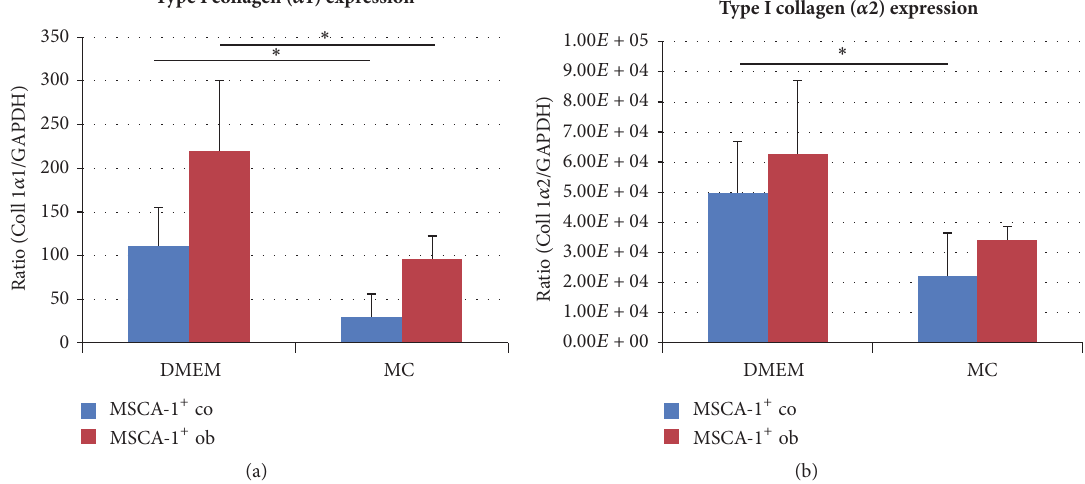
Figure 7: Quantitative PCR measurements of type I collagen ( 𝛼 1 and 𝛼 2 chain) gene expression levels in MSCA-1 + JPCs cultured under DMEM (serum-containing) and MC conditions (serum-free). (a) mRNA levels of type I collagen ( 𝛼 1 chain) and (b) ( 𝛼 2 chain) in relation to the housekeeping gene GAPDH are illustrated in untreated (co) and osteogenically induced (ob, for 10 days) MSCA-1 + cells. Statistical significances are indicated by asterisks: ∗ 𝑝 < 0.05